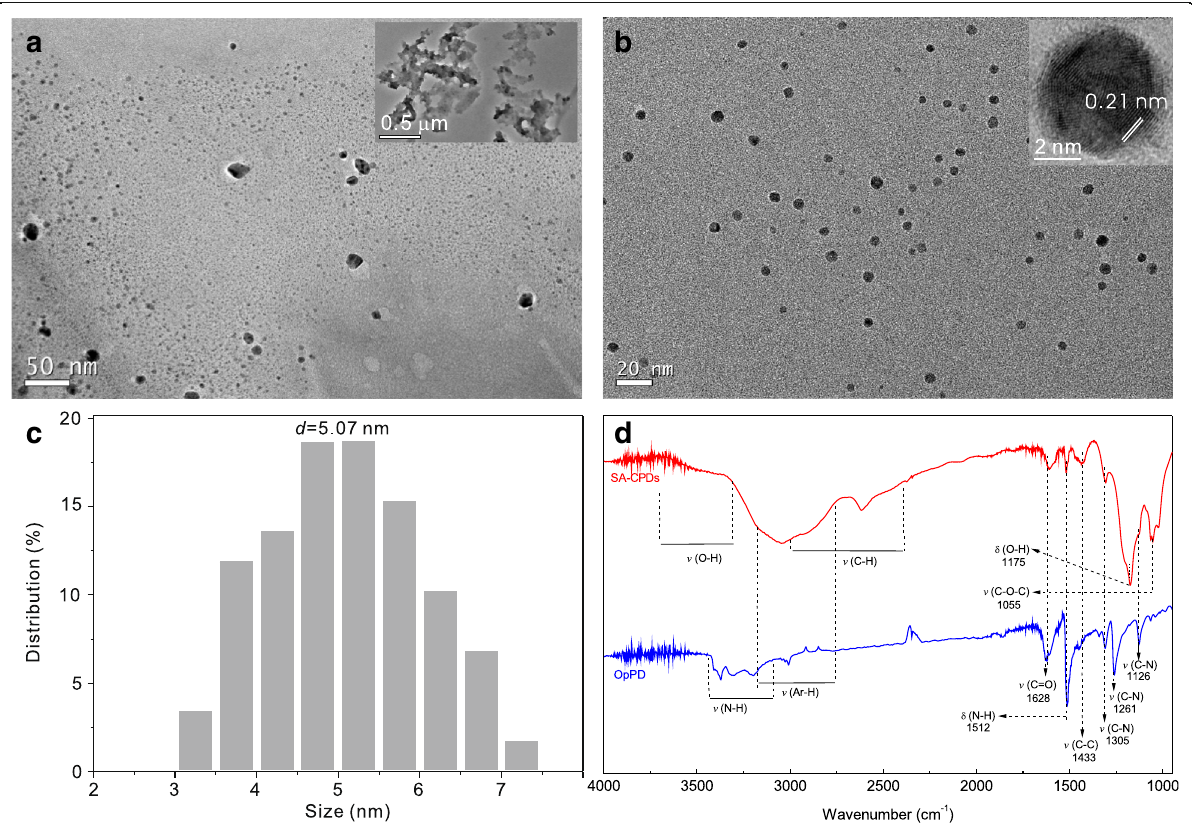
Fig. 1 TEM images of sample OpPD (without H 2 SO 4 ) ( a ) and SA-CPDs ( b ). c The size distribution of SA-CPDs. d The FT-IR spectra of sample OpPD and red CPDs. Sample OpPD and SA-CPDs were prepared from p -PD aqueous solution without and with H 2 SO 4